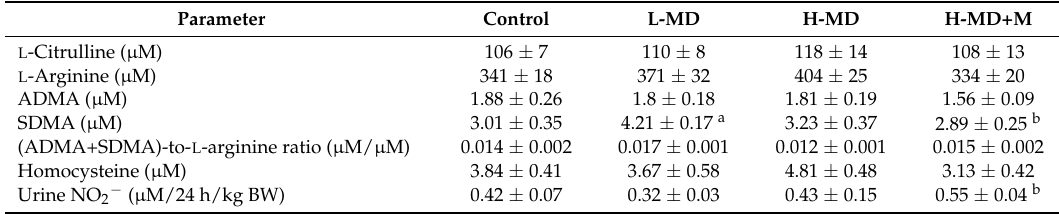
Table 4. Plasma and urine levels of NO-related parameters.